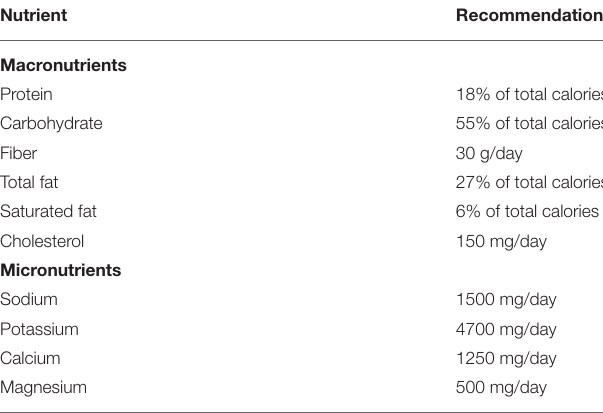
TABLE 3 | Antihypertensive DASH dietary goals for the Middle East*.